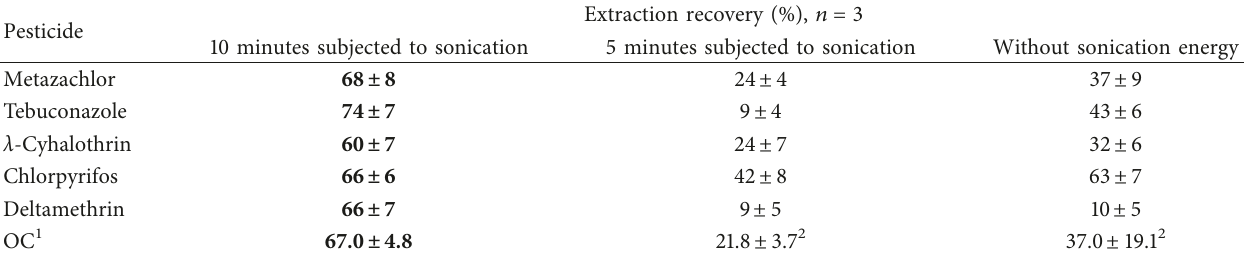
Table 4: Effect of the sonication energy and desorption time on extraction efficacy of the five pesticides from rape oil samples. Pesticide